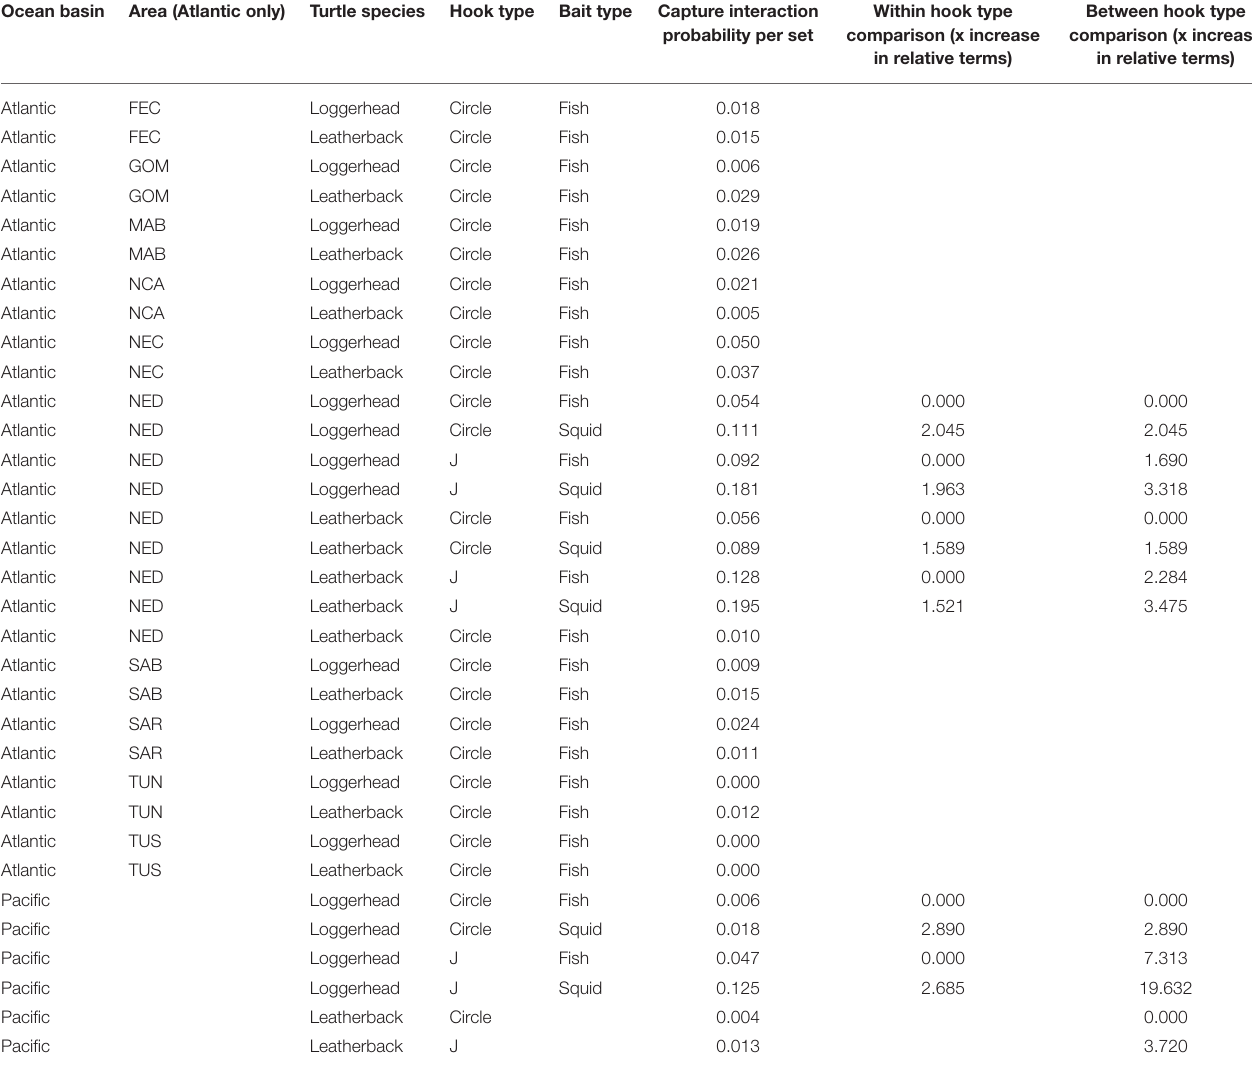
“Withinhook typecomparison” results represent thepercent increase for squid or“other” category baits relative to fishbait within each hook typecategory (Circle, J, orOther). “Between hook type comparison” results represent the percent increase for sets using J hooks or “other” category hooks with squid or “other” category baits relative to capture probabilities on circle hooks used with fish bait